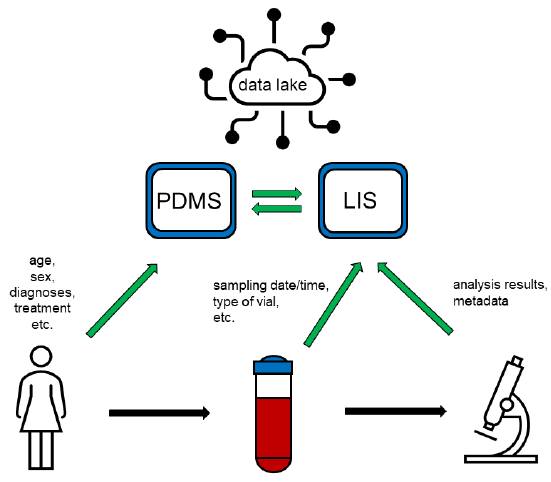
Figure 1. Patients’ data is entered into the patient data management system (PDMS), predominantly manually, while information about samples collected as well as about analyses conducted is entered into the laboratory information system (LIS), either manually or automatically. PDMS and LIS are connected and exchange parts of their stored data. Both systems feed a “data lake” comprising var- ious types of data, which can be provided to researchers for Big Data